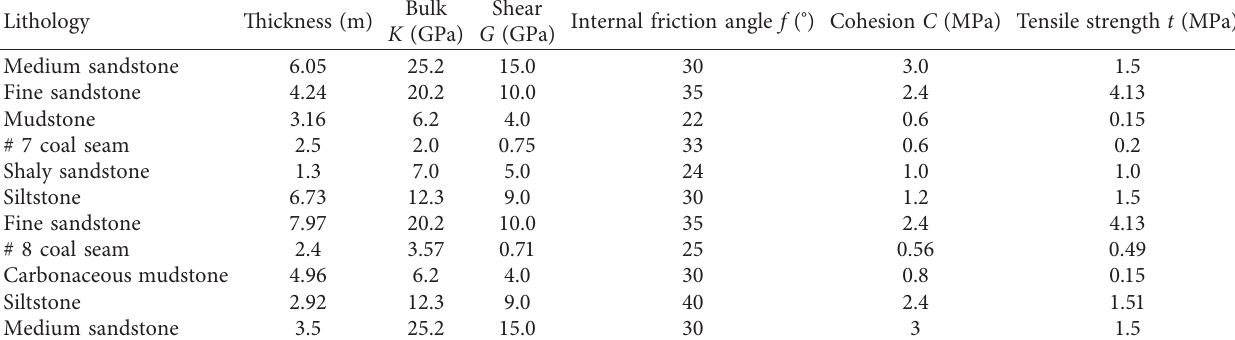
Table 2: The mechanical parameters of the surrounding rock.